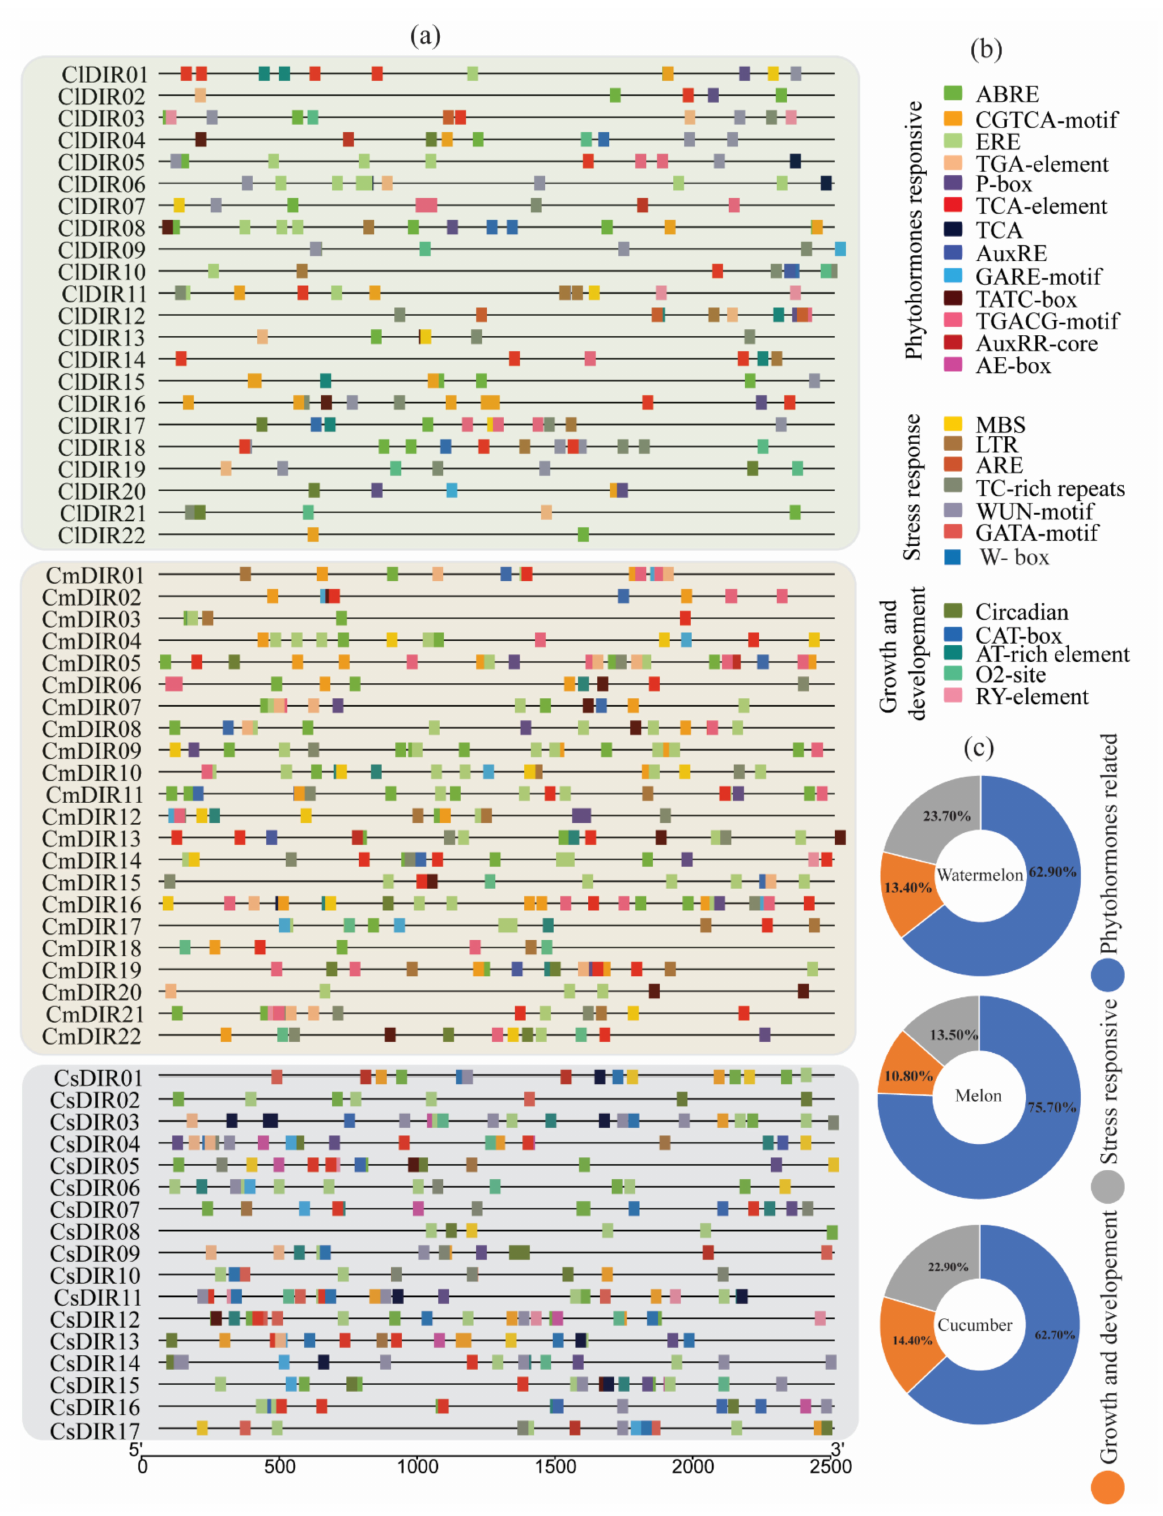
Figure 3. Cis -elements in the promoter regions of ClDIR, CmDIR and CsDIR genes. Different colors denote different cis -elements and classification is done according to their role in different activities. ( a ) Distribution of important cis -elements on promoter region, ( b ) Classification of cis -elements according to their function. ( c ) The ratio of various cis -elements in three different categories is presented in pie